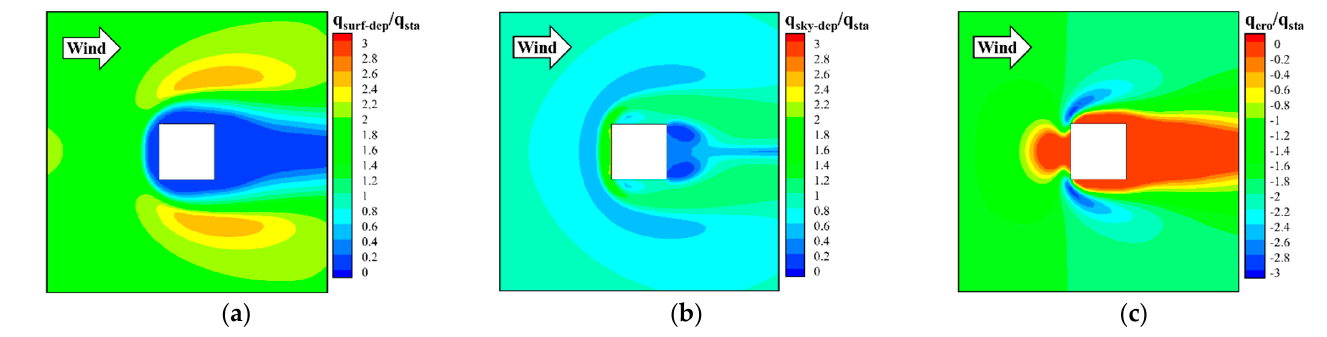
Figure 8. Normalized deposition flux of two types of snow phases and erosion flux: ( a ) normalized deposition flux of drifting snow; ( b ) normalized deposition flux of falling snow; ( c ) normalized erosion flux.